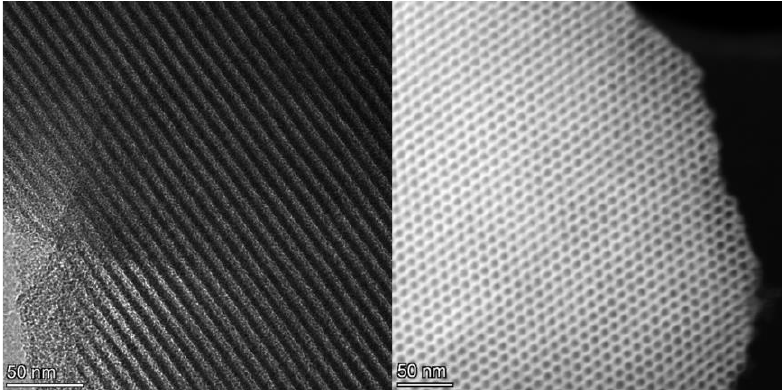
Figure 2. TEM images of 5%Zr-SBA-15.